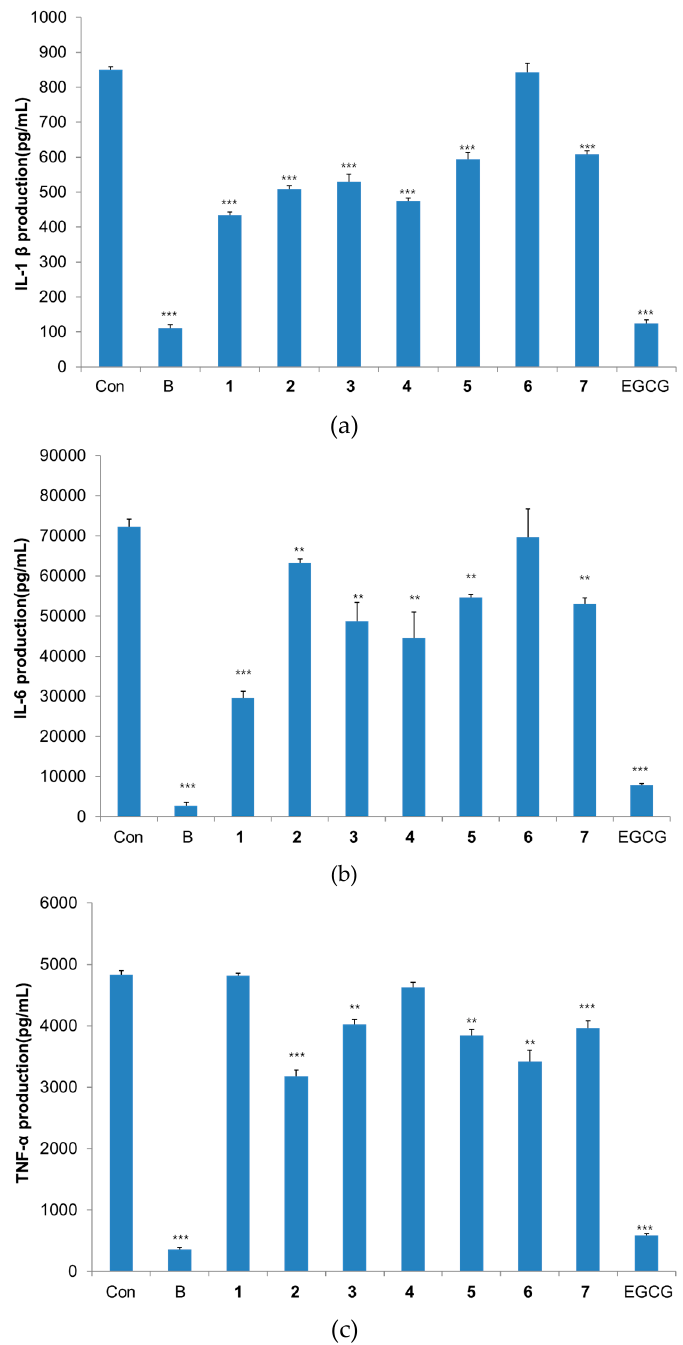
Figure 2. Inhibitory activities on cytokines production in THP-1 macrophage cells. Results are expressed as mean ± S.D. ( n = 3). ** p < 0.01, *** p < 0.001 versus control group. Con, negative control group; B, blank group (normal); EGCG, positive control. ( a ) IL-6 production inhibitory activity; ( b ) TNF- α production inhibitory activity; ( c ) IL-1 β production inhibitory activity.